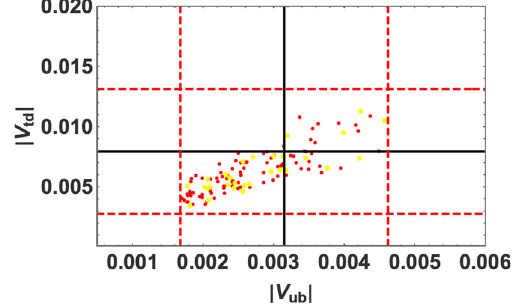
Fig. 6 The CP phase of quark δ versus (1, 3) component of CKM matrix. The red dashed lines represent 3 σ experimental bounds (cid:19) m i